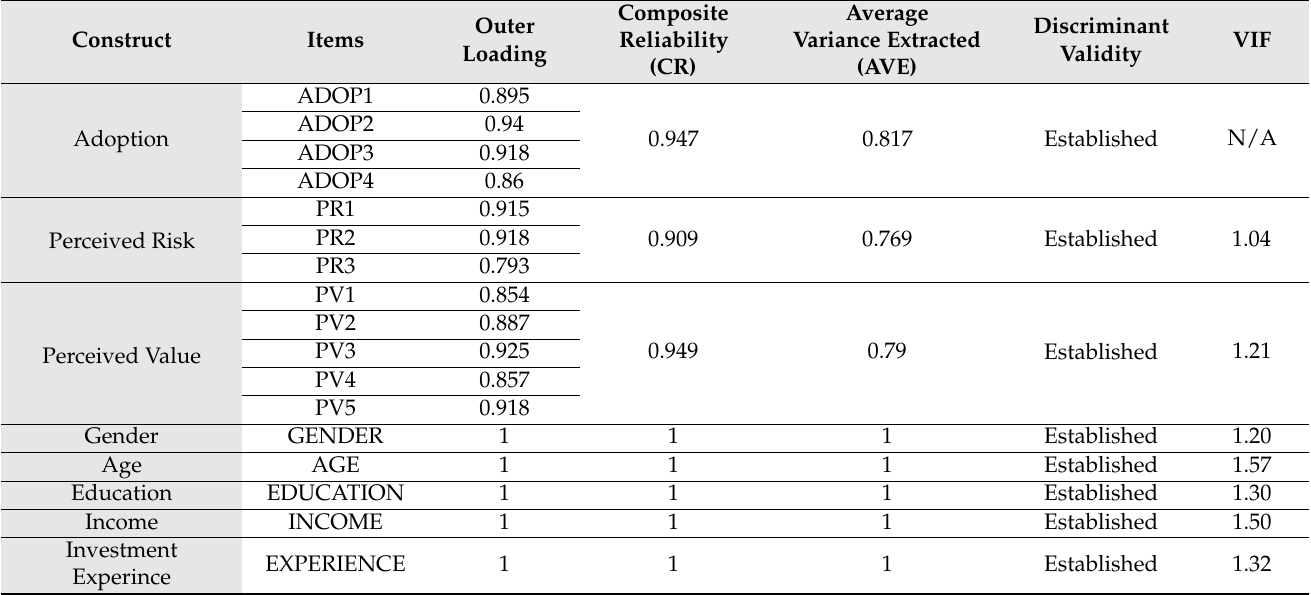
Table 4. Results of the validity and reliability test.